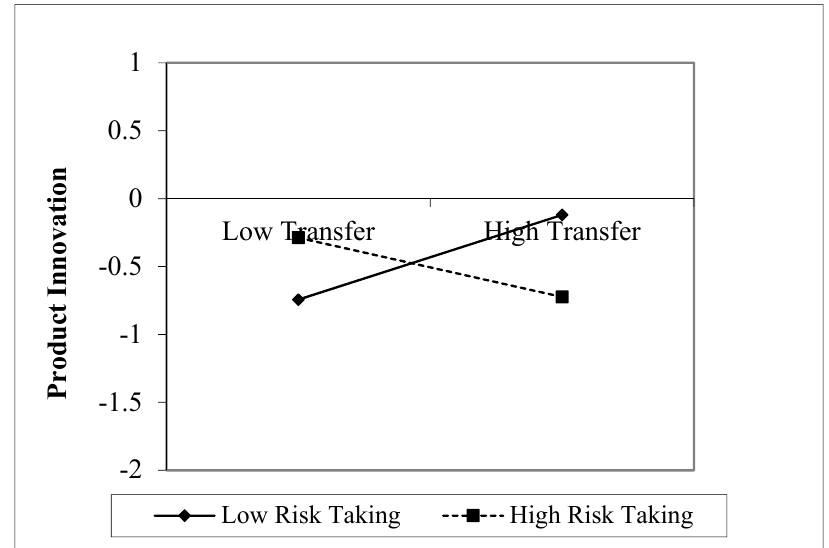
Figure 5. The moderating effect of risk-taking on the knowledge transfer–product innovation relationship. Source: Own elaboration.